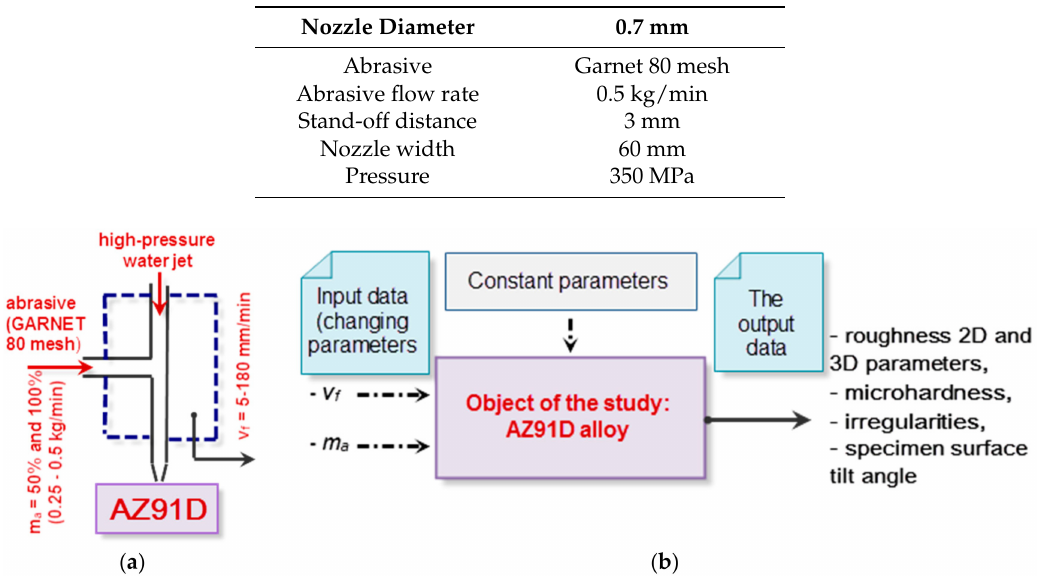
Figure 2. Schematic diagram ( a ) and test set-up ( b ) with the object of the